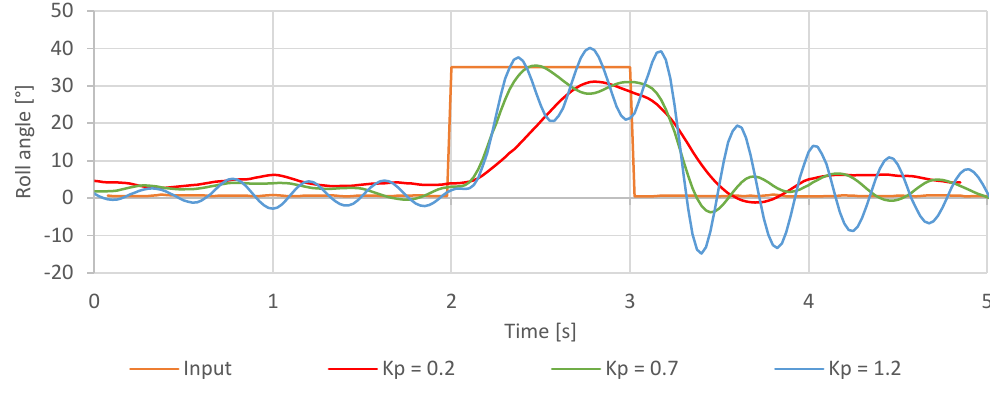
Figure 21. Step response of the roll axis controller for different Kp values.